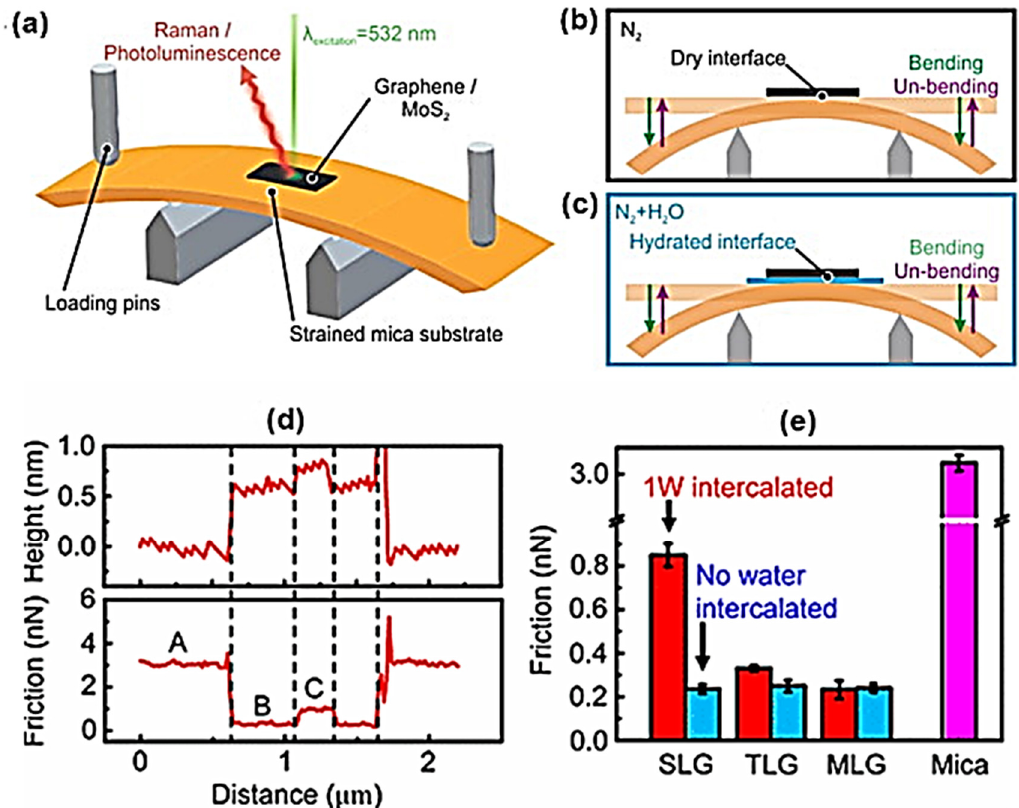
Figure 4. Hydration and strain transfer test between the interfaces of mica substrate and 2D materials: ( a ) Illustration of the four-point bending setup. Strains in graphene and MoS 2 flakes were, respectively, detected with Raman and photoluminescence (PL) peak positions, for both ( b ) dry and ( c ) hydrated interfaces. Reproduced with permission from [73]. Copyright 2019 Elsevier. ( d ) Line graph of the height (top) and friction (bottom) obtained by subtracting the retrace from the trace signals along the solid red lines A–C. ( e ) Comparison of the friction force on the graphene regions with various numbers of stacked graphene layers, with and without intercalated water. SLG, TLG and MLG represent single-, tri- and multilayer graphene on the mica substrate, respectively. The red bars show a monolayer (1W) of intercalated water. The blue bars indicate friction without intercalated water. The purple bar on the right indicates bare mica. Reproduced with permission from [74]. Copyright 2017 American Chemical